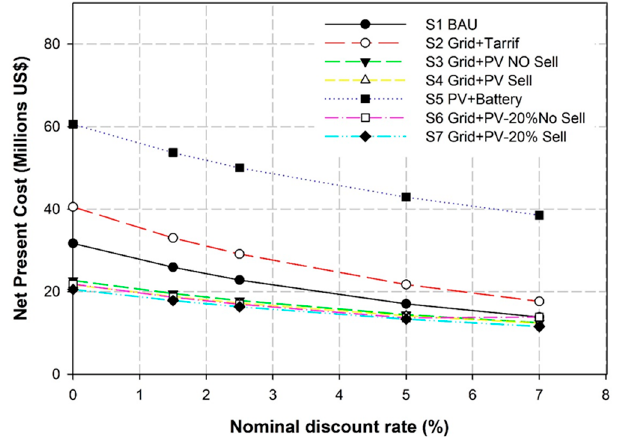
Figure 10. Net present cost for each scenario at different nominal discount rates.